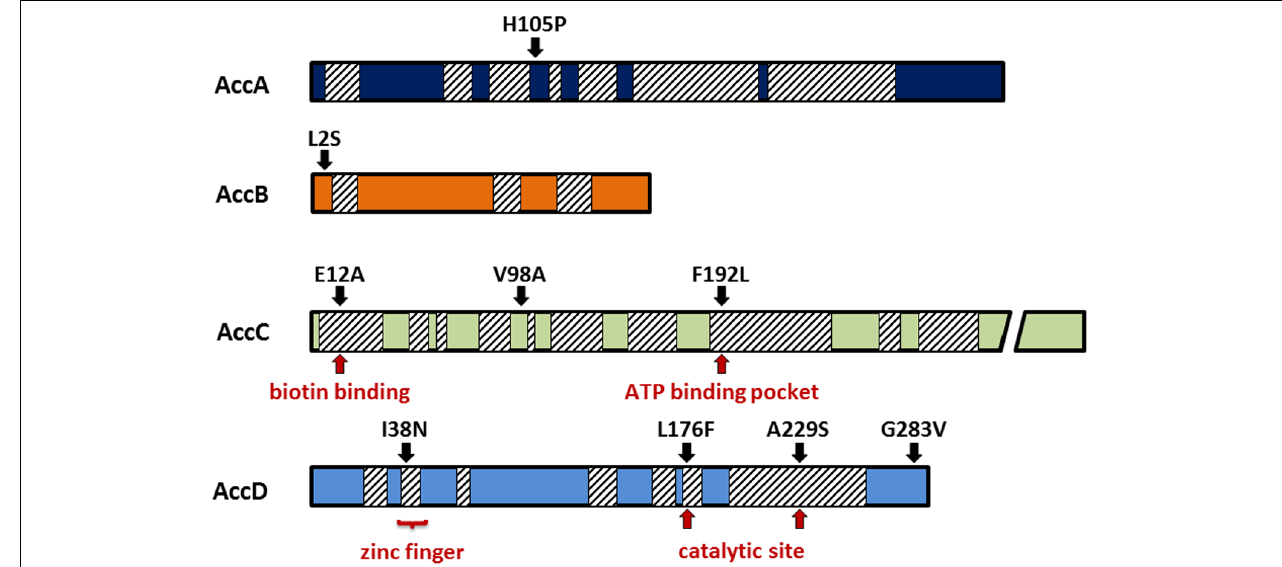
FIGURE 4 | Mutations in the acetyl-CoA carboxylase subunits. All mutations were single substitutions obtained from distinct clones. Many of them were located in highly conserved regions (hatched boxes) responsible for substrate binding or catalytic activity.